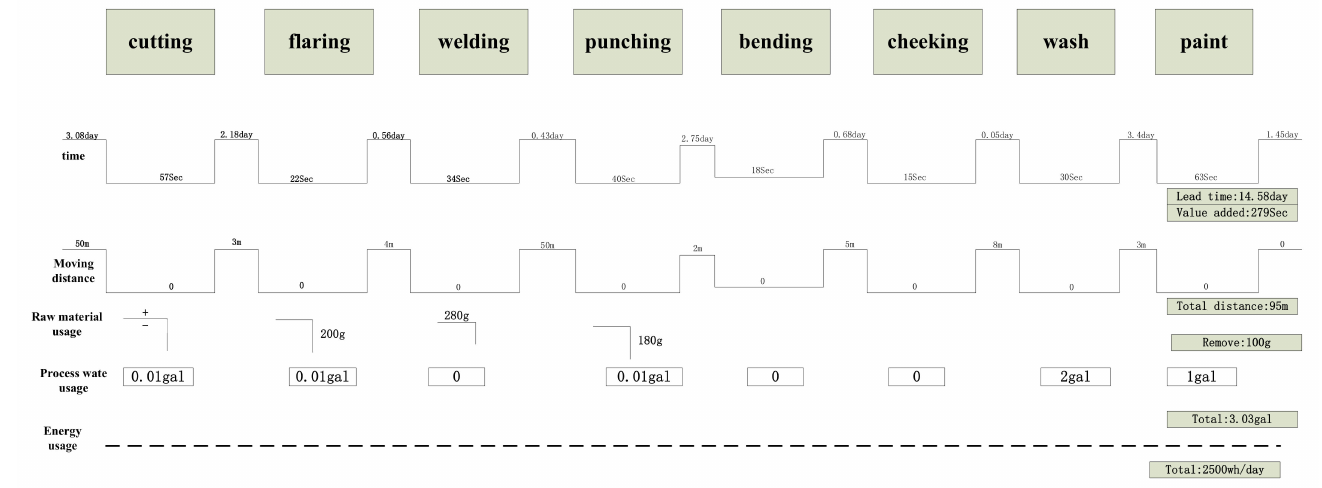
Figure 6. Resource consumption of satellite dish kit production line (before